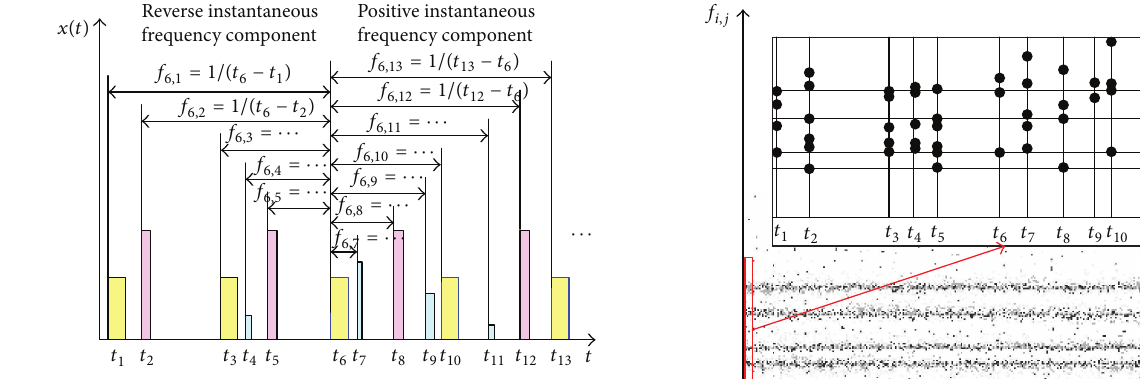
Figure 6: Schematic diagram of instantaneous frequency compo- nent calculation.